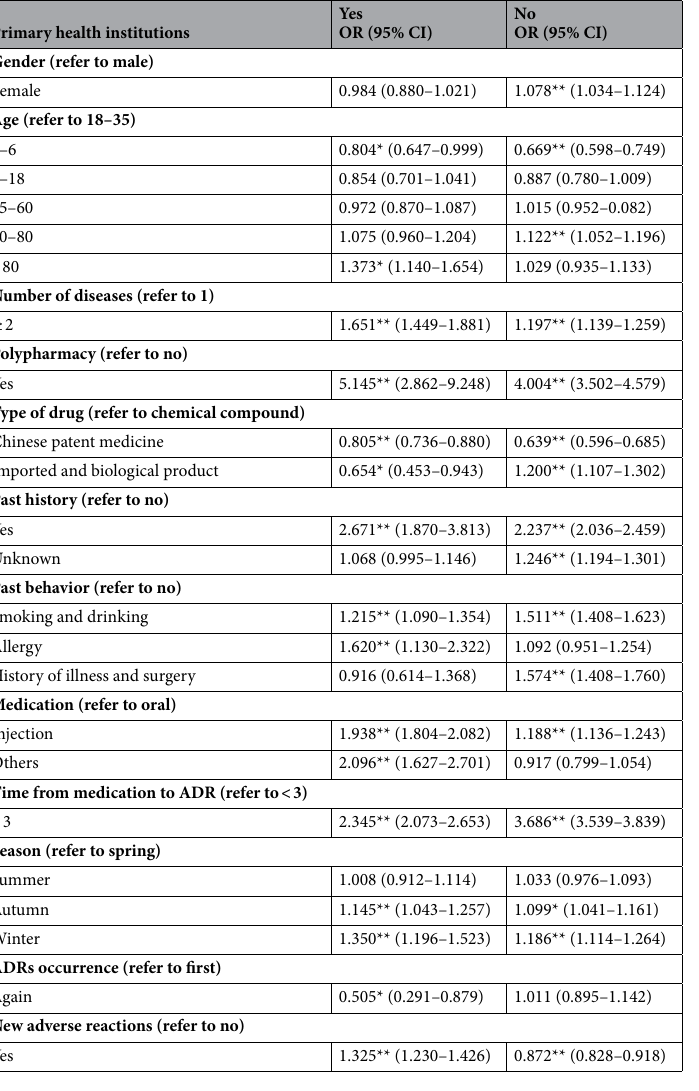
Table 4. ADRs in primary and non-primary medical institutions lead to results. OR odds ratio, CI confidence interval. * p < 0.05, ** p <